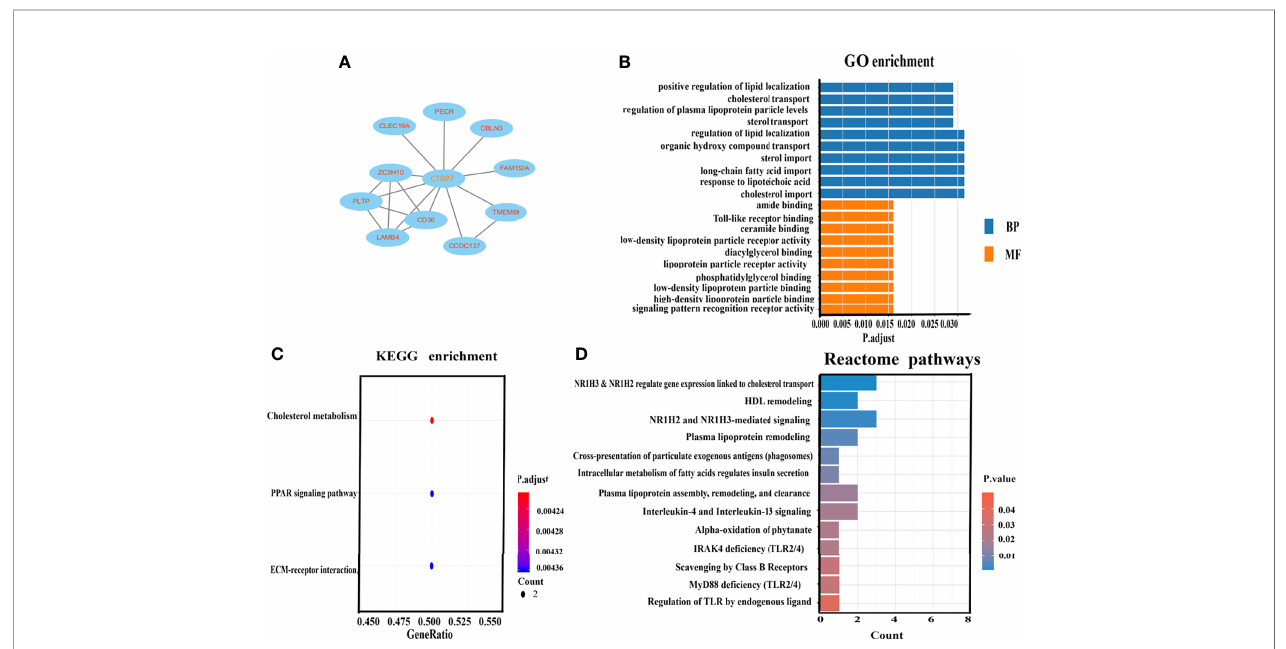
FIGURE 3 | Bioinformatic analysis for CTRP7-related genes and signaling pathways. (A) Protein-protein interaction (PPI) network. (B) GO enrichment analysis for biological process (BP) and molecular function (MF). (C) KEGG enrichment analysis of the pathways. The gradual color represents the P-value. The size of the bubble represents the gene number. (D) REACTOME analysis for enriched pathways. The X-axis represents the number of involved genes. The Y-axis represents the pathway terms. GO, Gene Ontology; KEGG, Kyoto Encyclopedia of Genes and Genomes.